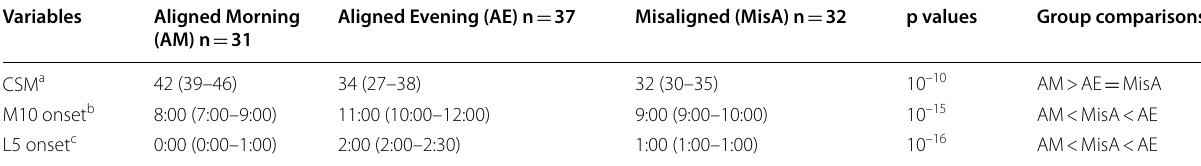
CSM: Composite Scale of Morningness. Reported values represent medians and Interquartile ranges a A lower CSM scores is indicative of an evening type (range: 13–55)